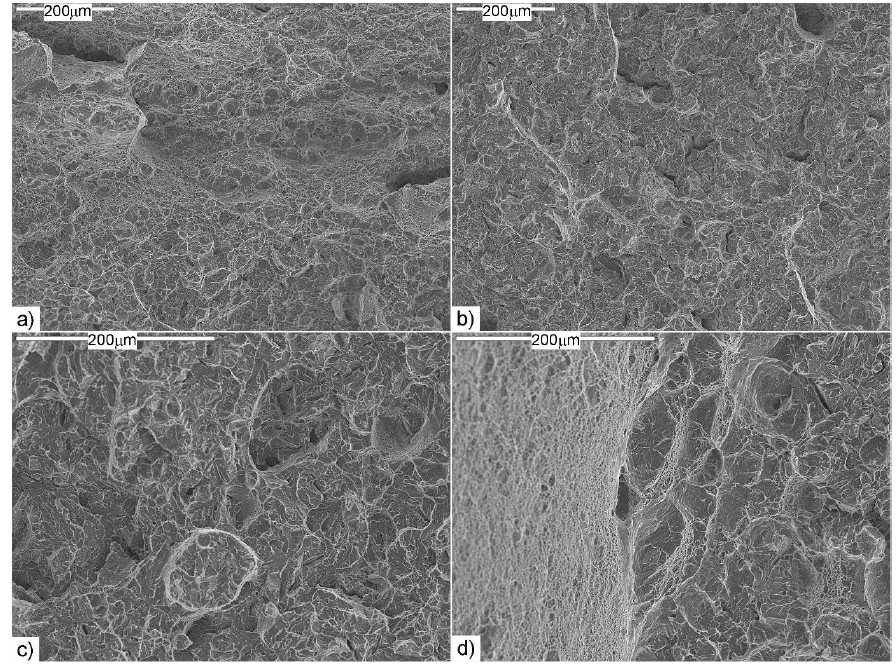
Figure 12. Fracture of the tested sample in the as-received state: ( a ) the zone under the mechanical notch; ( b ) the quasi-brittle central zone with visible ductile area; ( c ) the central zone with visible “small column”; ( d ) transition between the plastic lateral zone and the quasi-cleavage zone, SEM.